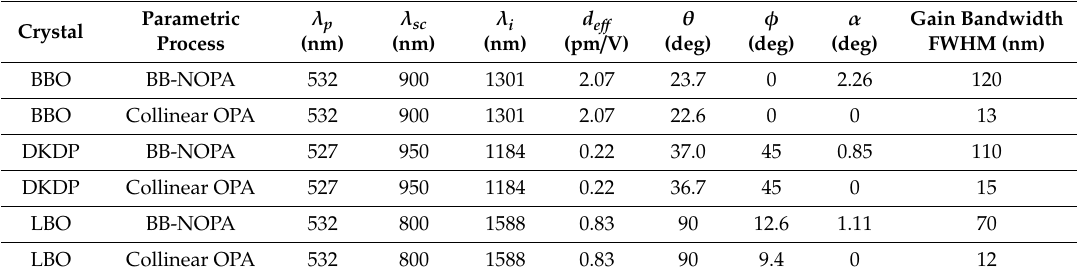
Figure 14. The simulated gain bandwidth in non-linear crystals for broad-band (BB) phase-matching NOPA compared with collinear narrow-band OPA, at given λ sc signal central wavelengths. Pump beam intensity, I p = 1 GW / cm 2 . Crystal lengths were chosen to get similar gains for all parametric processes. ( a ) BBO crystal, red line NOPA, black line collinear OPA, L BBO = 9.9 mm, 532 nm Nd:YAG pump laser wavelength. ( b ) DKDP crystal, green line NOPA, black line collinear OPA, L DKDP = 77 mm, 527 nm Nd:glass pump laser wavelength ( c ) LBO crystal, blue line NOPA, black line collinear OPA, L LBO = 24.4 mm, 532 nm Nd:YAG pump laser wavelength. Table 4. The calculated main parameters of the BB-NOPA and narrow-band collinear OPA.